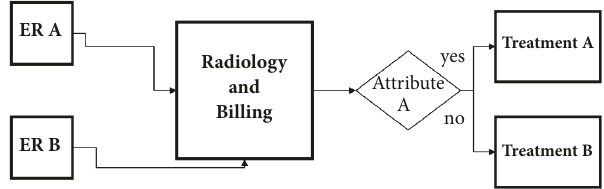
Figure 4: Petri net model